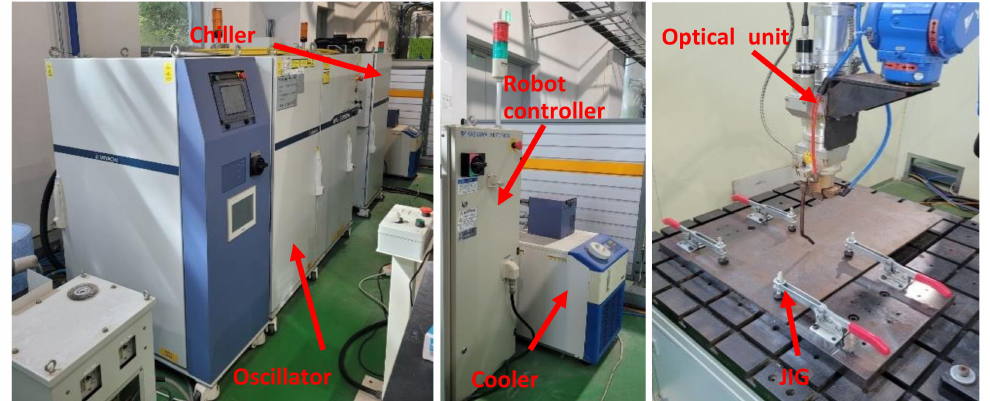
Figure 2. Fiber laser welding system. After the BOP welding, a specimen was collected at a position of 120 mm, which is in the middle of each BOP welding length of 240 mm and a cross-sectional observation was performed. After cross-sectional observation, the penetration size was measured for each condition. Five measurements were taken: Top HAZ (Heat Affected Zone) width, top bead width, bottom HAZ width, HAZ depth and penetration. They are shown as Figure 3.